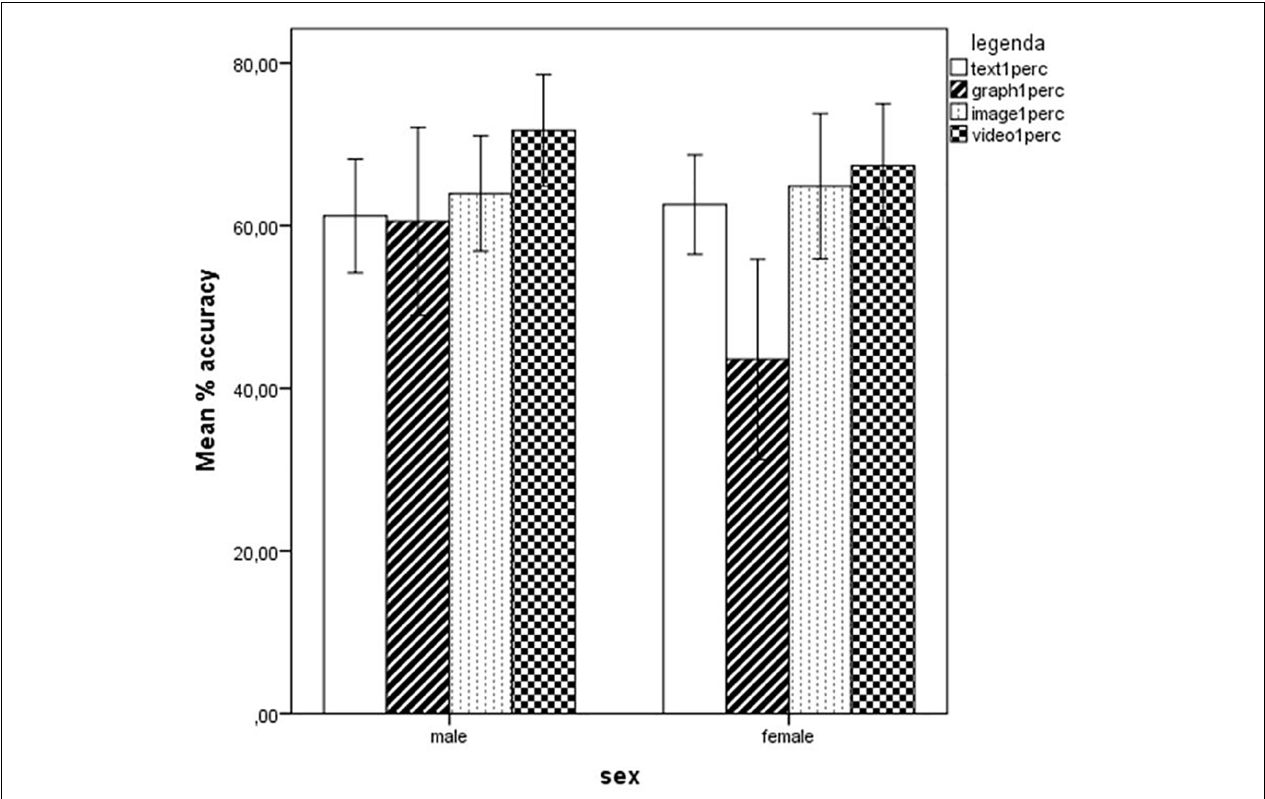
FIGURE 6 | Results obtained by males and females on the four subscales Text, Graph, Image, and Video, expressed as percent scores. Error bars illustrate 95% Confidence Intervals for the Mean.